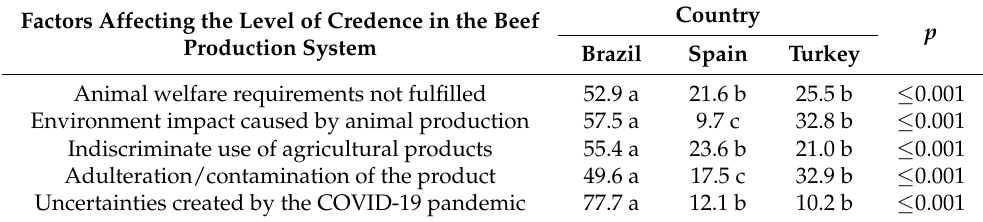
Table 6. Credence factors in beef production system that negatively affect the purchase intention of beef of Brazilian, Spanish, and Turkish